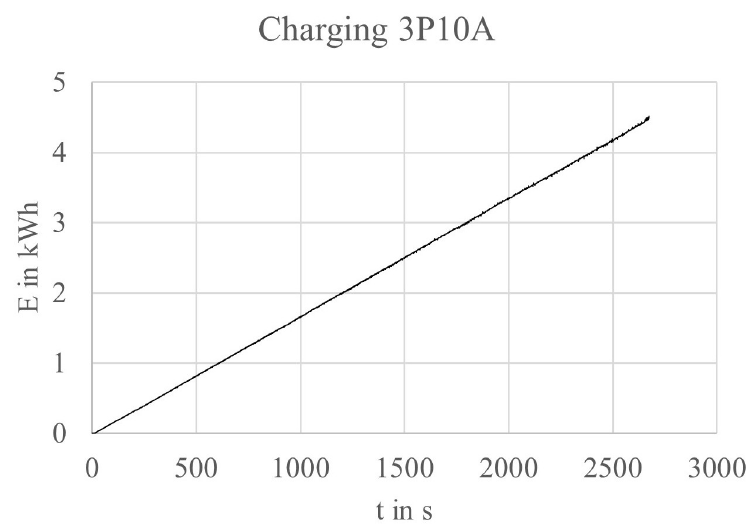
Figure 5. Accessed charged energy data after completing a WLTC.